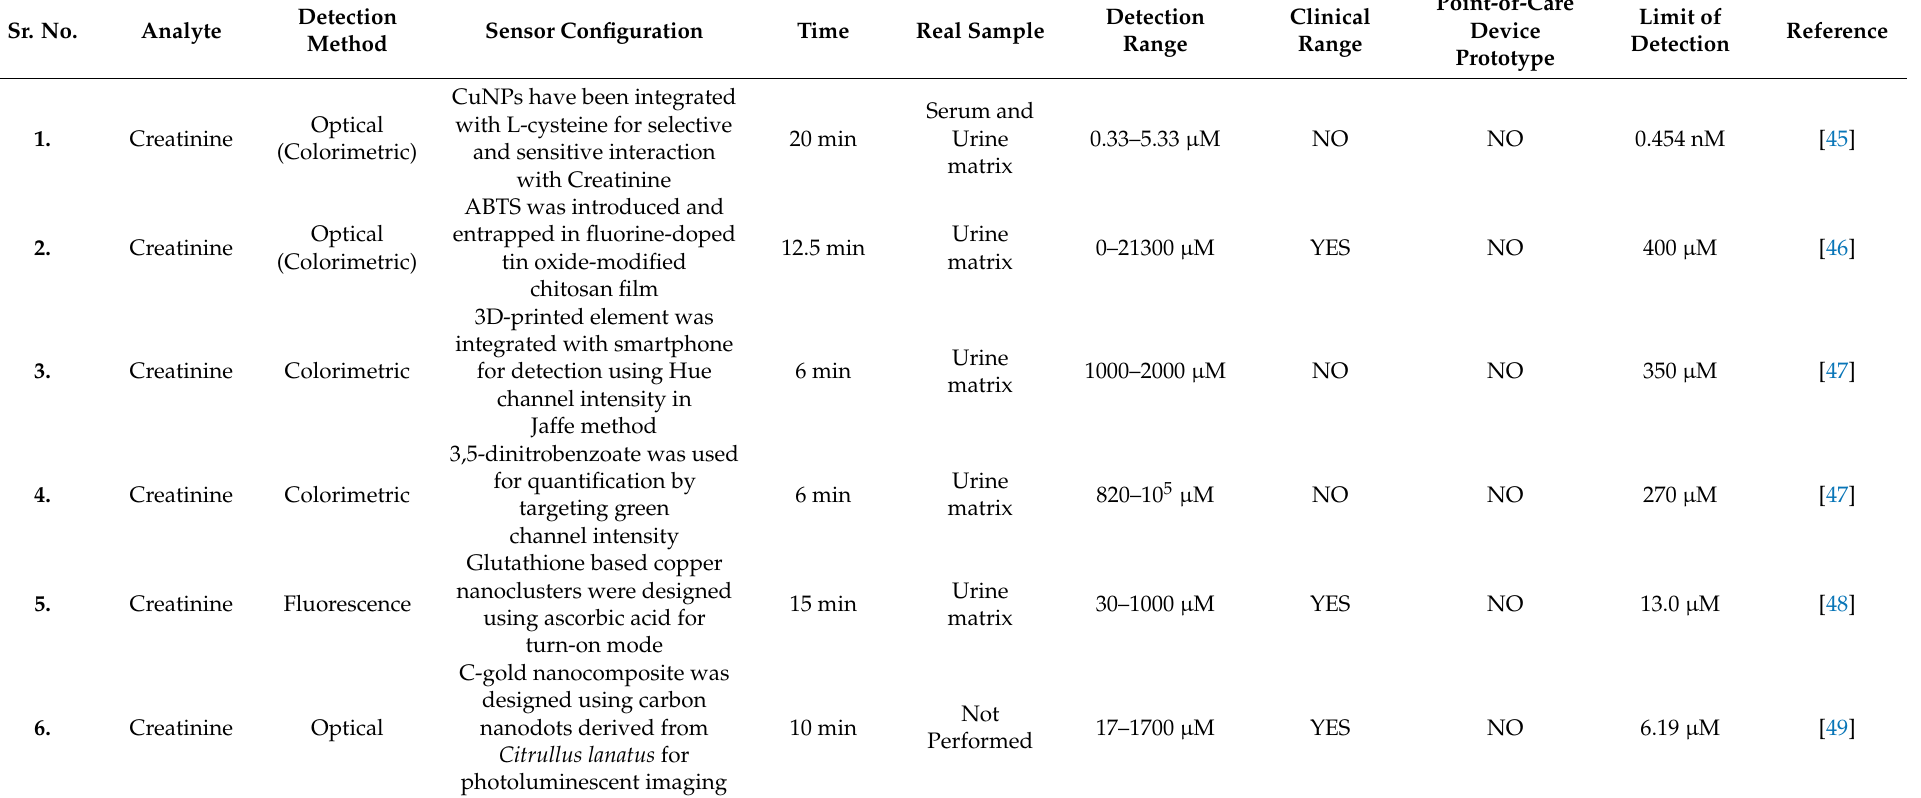
Table 1. Comparison table of some globally developed creatinine sensors with the developed setups in terms of fabrication, response time, analytical performance.